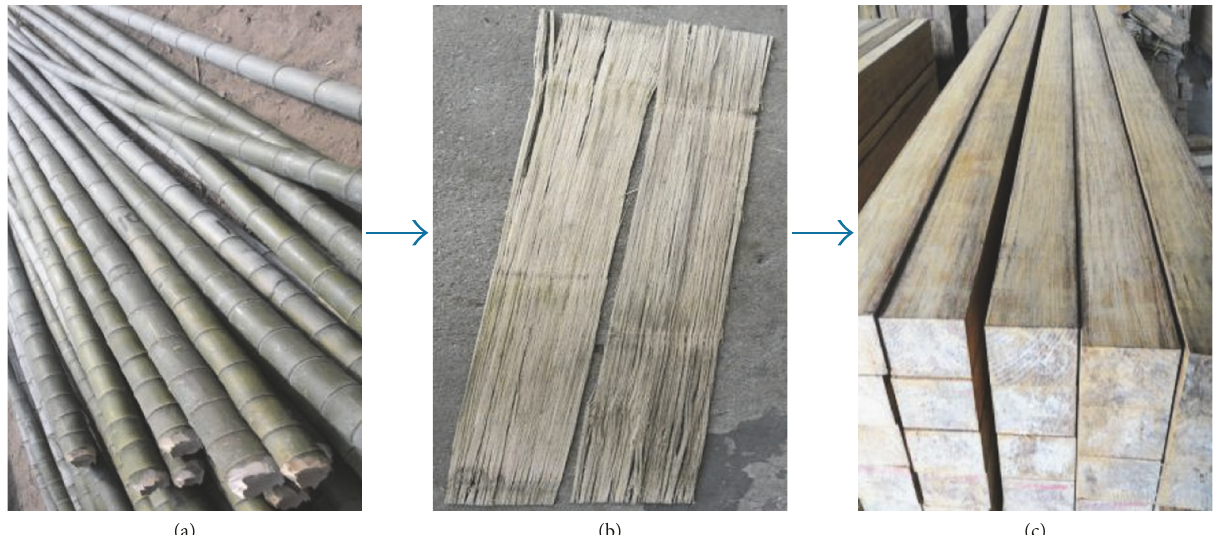
Figure 1: Manufacturing process of parallel strand bamboo. (a) Raw bamboo. (b) Bamboo fiber bundle. (c) Parallel strand